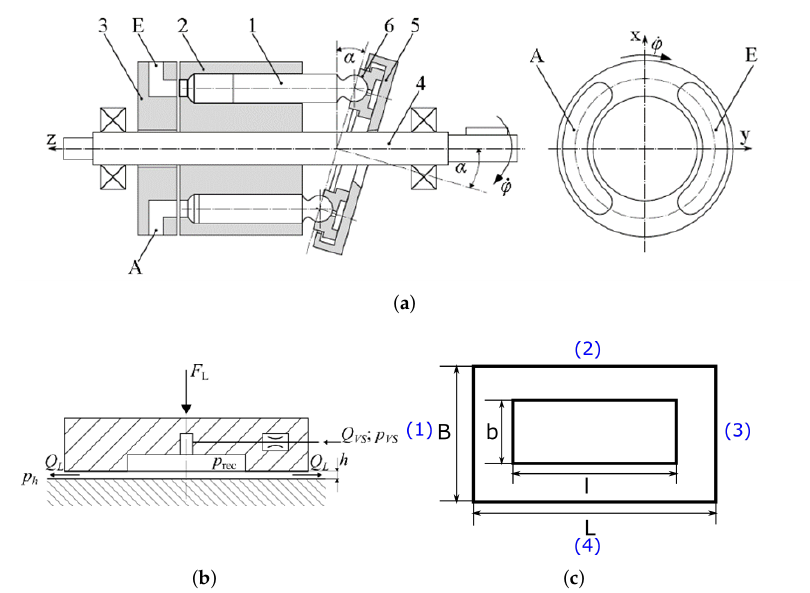
Figure 1. Illustration of the leakage at cradle bearing in an Axial piston pump. ( a ) Structure of an axial piston pump in swash plate design with distributor plate [30]. 1: piston, 2: cyliner, 3: distributor plate, 4: axis, 5: swashplate, 6: sliding shoes, E: inlet, A: outlet, α : Swashplate displacement ˙ φ : rotation velocity. ( b ) Pressure distribution at cradle bearing with hydrostatic lubrication. ( c ) A example of cradle bearing leakage model at